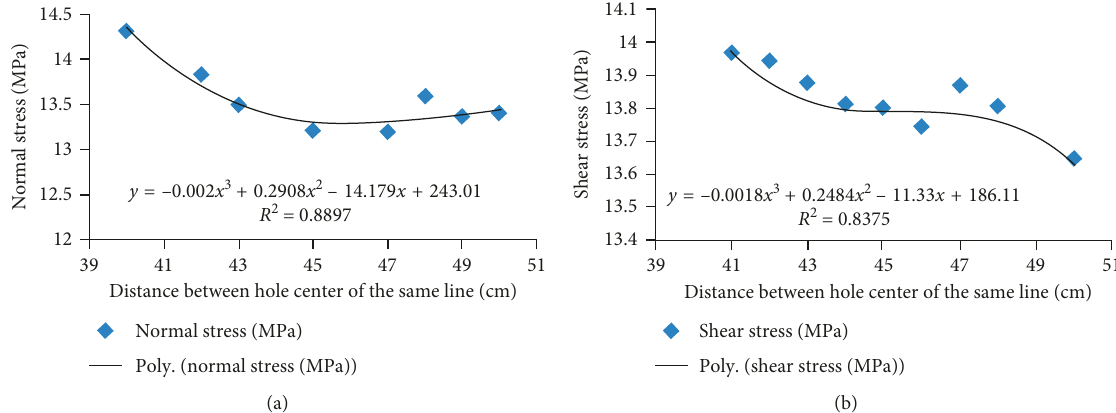
Figure 18: Maximum normal stress (a) and shear stress (b) versus distance between holes in the same line in the staggered mesh.